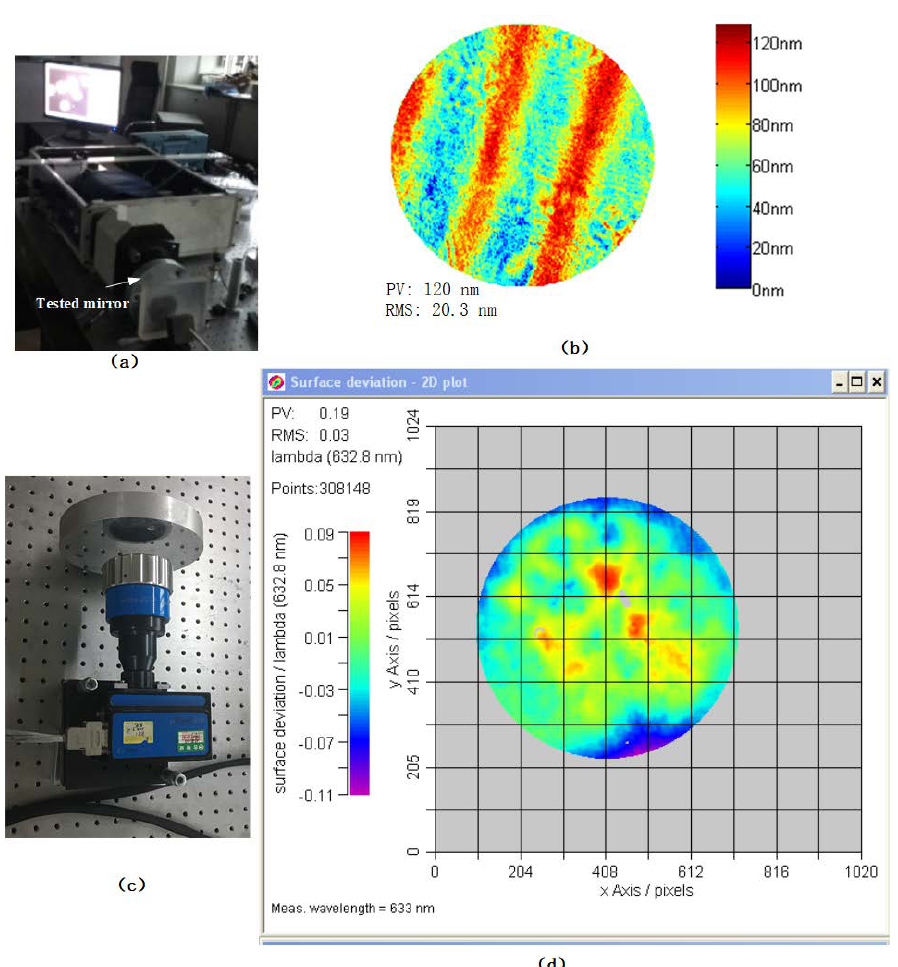
Figure 9. Comparative test. ( a ) MFI measurement; ( b ) result of the MFI; ( c ) μshape2 HR measurement; and ( d ) result of μshape2 HR.